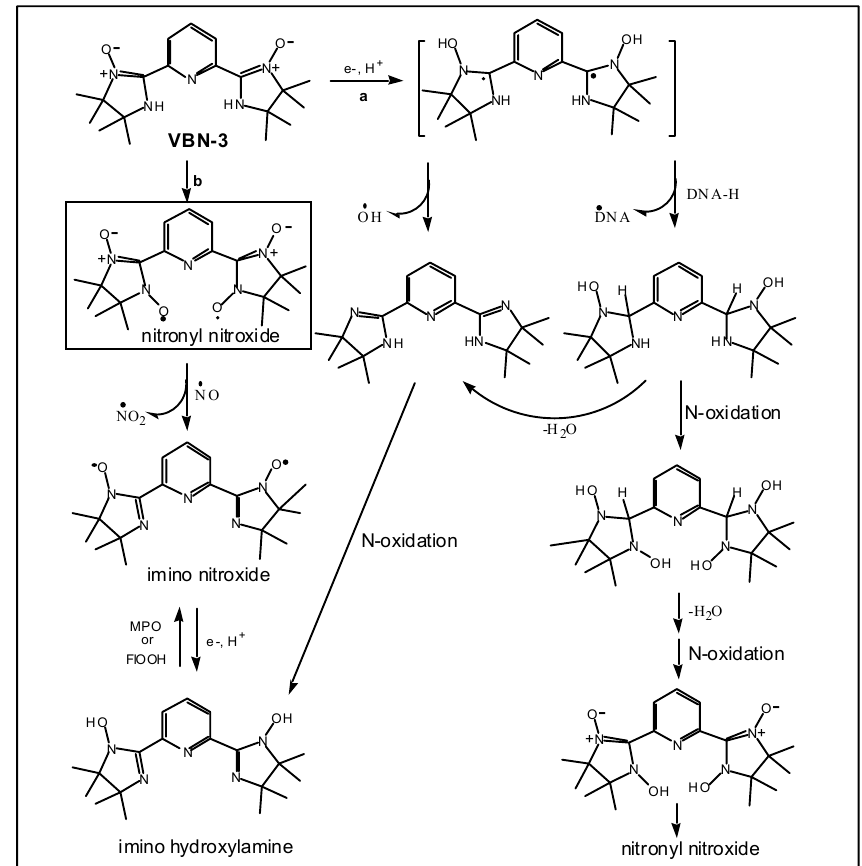
Scheme 5. Hypothetical pathways postulated for (a) reductive and (b) oxidative activation of VBN-3 (from Reference